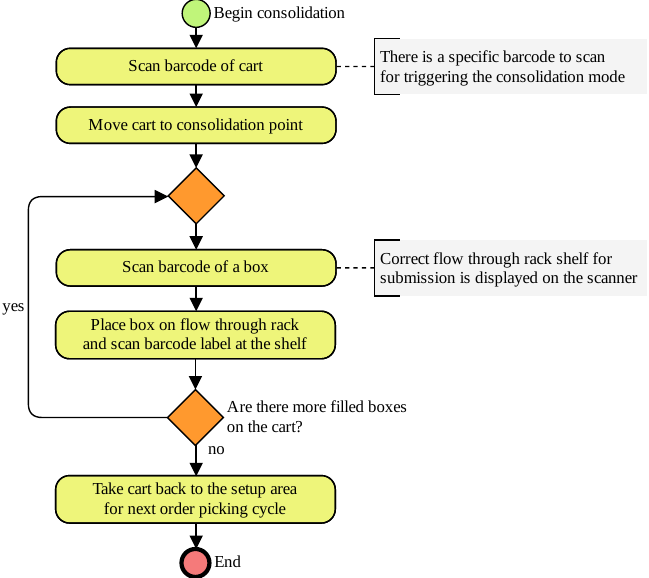
Figure 4. Business process model of logistics Scenario 2 (Part 2)—real warehouse order picking.